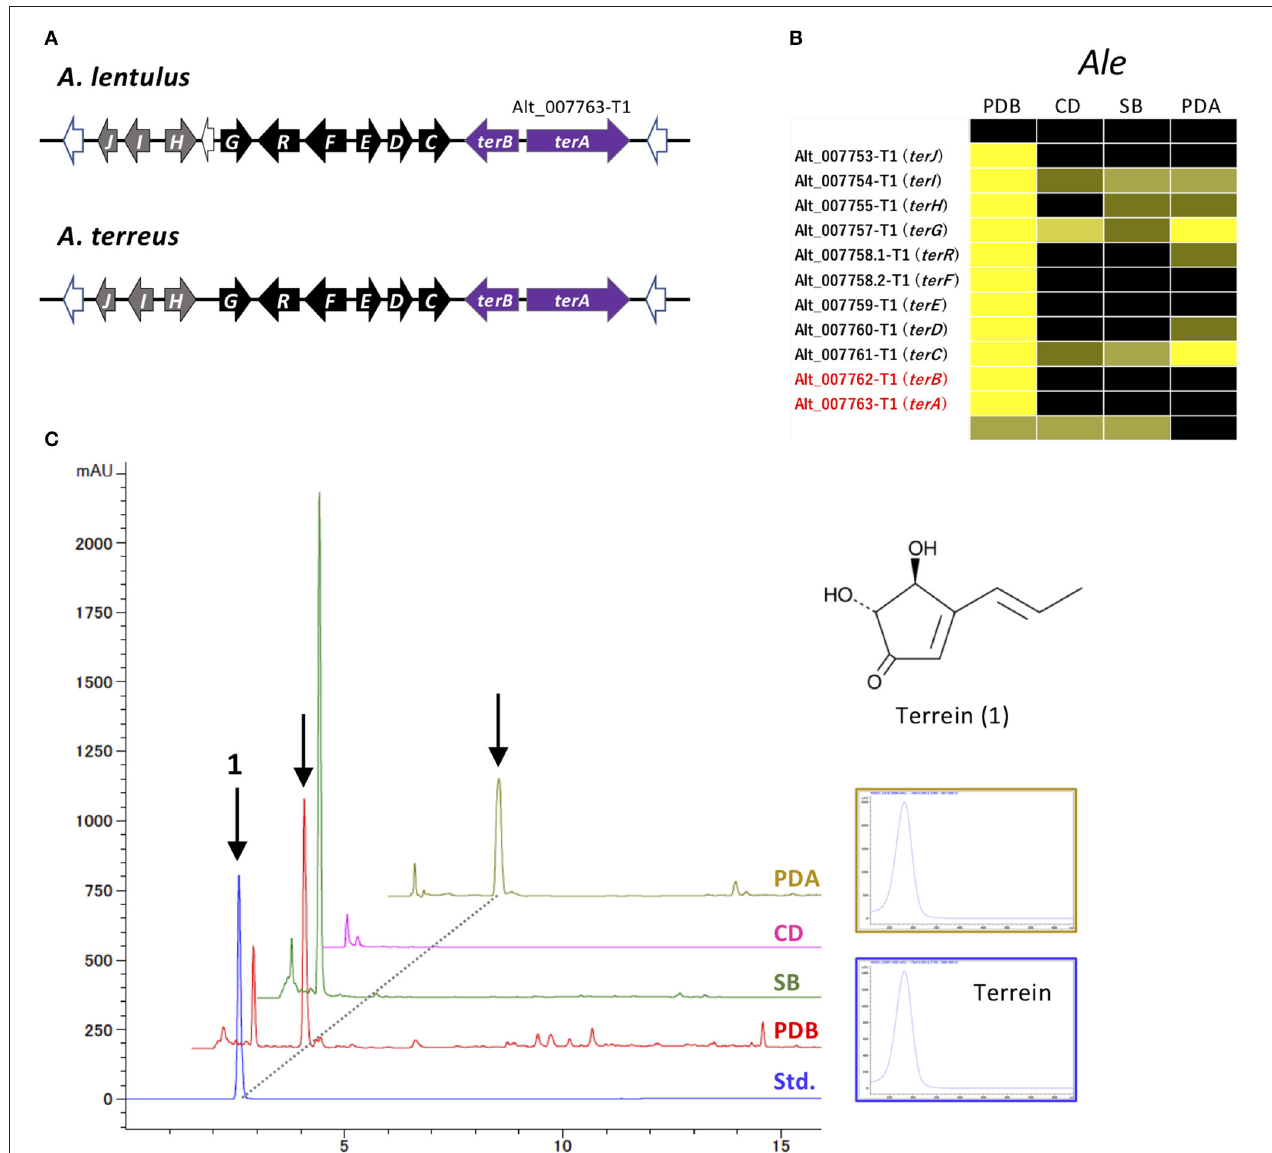
FIGURE 6 | Characterization of the ter cluster and terrein production in A. lentulus . (A) Schematic structure of the ter cluster in A. lentulus and A. terreus . The SM backbone genes (PKSs) are indicated by purple arrows. Genes ( terG , terH , terI , and terJ ) whose involvement in terrein production remains obscure in A. terreus are indicated by gray arrows. (B) The expression profiles of ter genes in A. lentulus shown using a heat map. (C) The production of terrein in A. lentulus . The strains were cultivated in PDB, SB, CD, and PDA, and ethyl acetate-derived culture extracts were analyzed using high-performance liquid chromatography. Terrein ( 1 ) production was identified by comparison with the standard compound (Std.). The corresponding peaks are indicated by arrows, and the UV spectrum from a PDA culture is compared with that of the standard